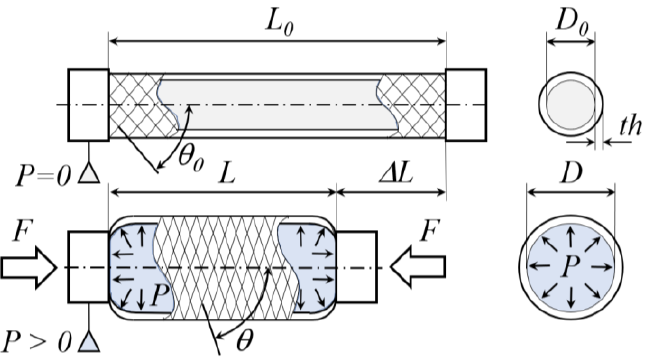
Figure 1. The working principle of the MKM detailing its significant geometrical and functional parameters.